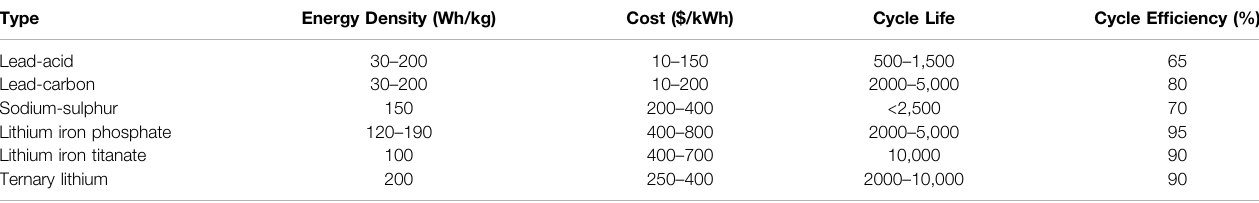
TABLE 1 | Technical characteristics of different types of